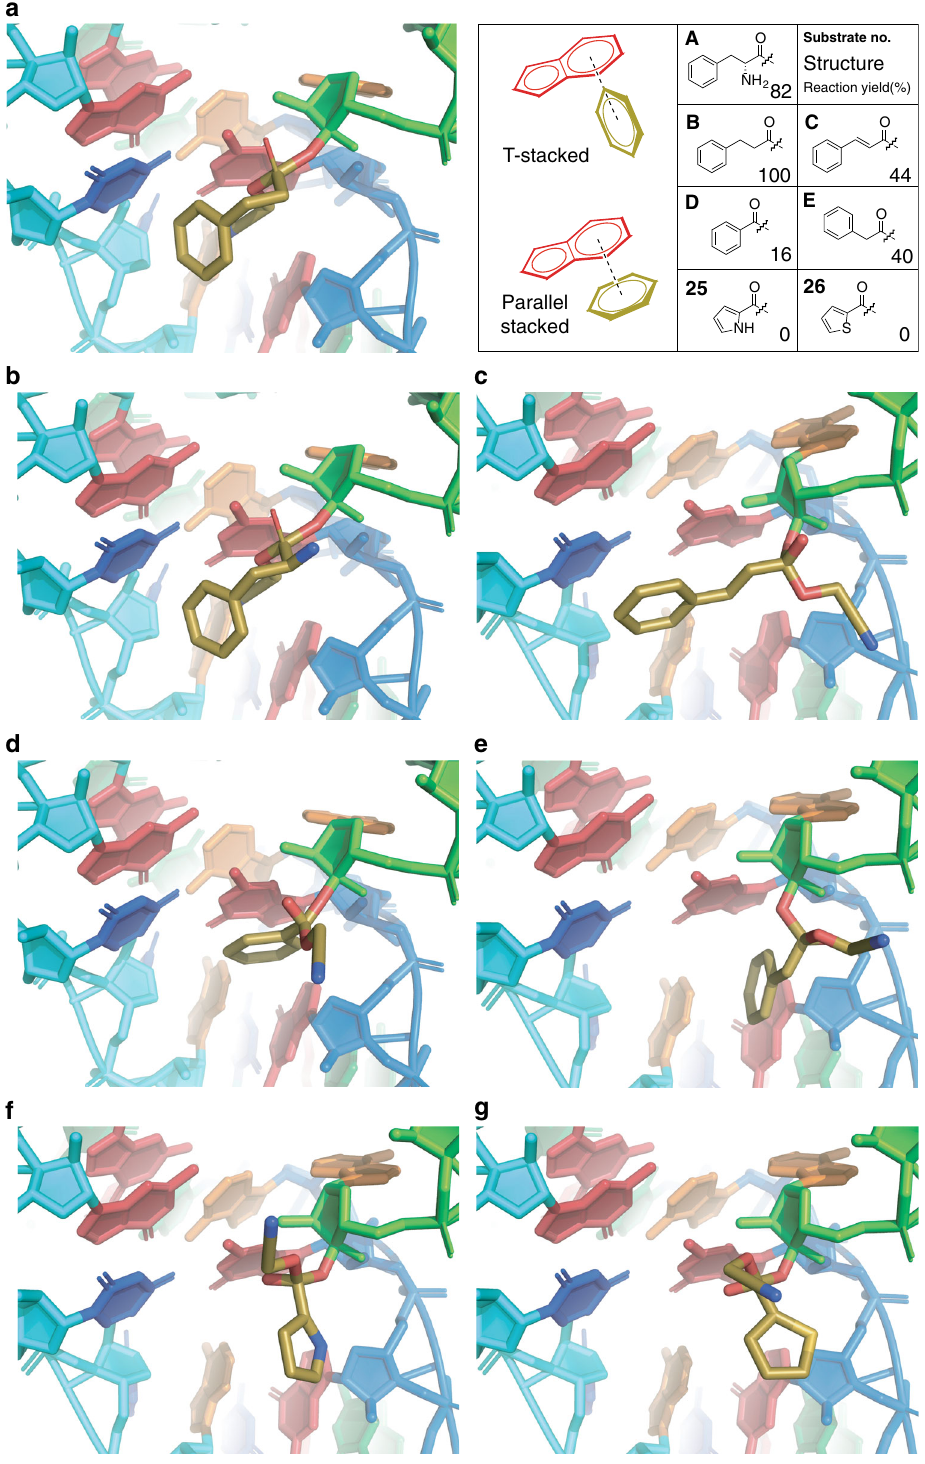
Fig. 4 Simulated molecular interactions between selected substrates and the binding pocket of eFx. Tetrahedral intermediate models of the CME esters were optimized and subjected to Monte Carlo energy optimization via Rosetta. Dark yellow represents a Phe ( A ), b hydrocinnamic acid ( B ), c cinnamic acid ( C ), d benzoic acid ( D ), e phenylacetic acid ( E ). No strong interaction with the guanine residue (top red) is observed for f pyrrole-2-carboxylic acid ( 25 ) and g 2-thiophenecarboxylic acid ( 26 ); (green: substrate-charged